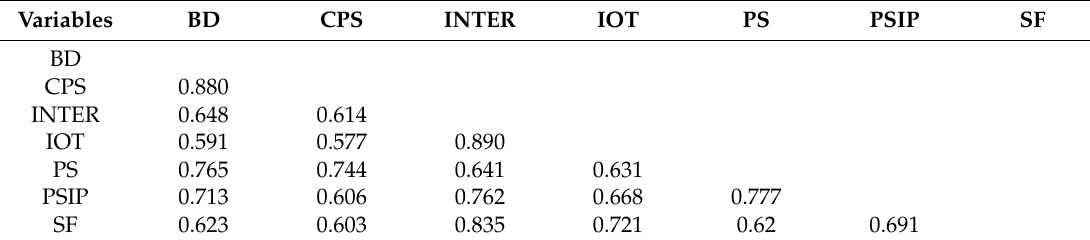
Table 4. Heterotrait–monotrait ratio of correlations